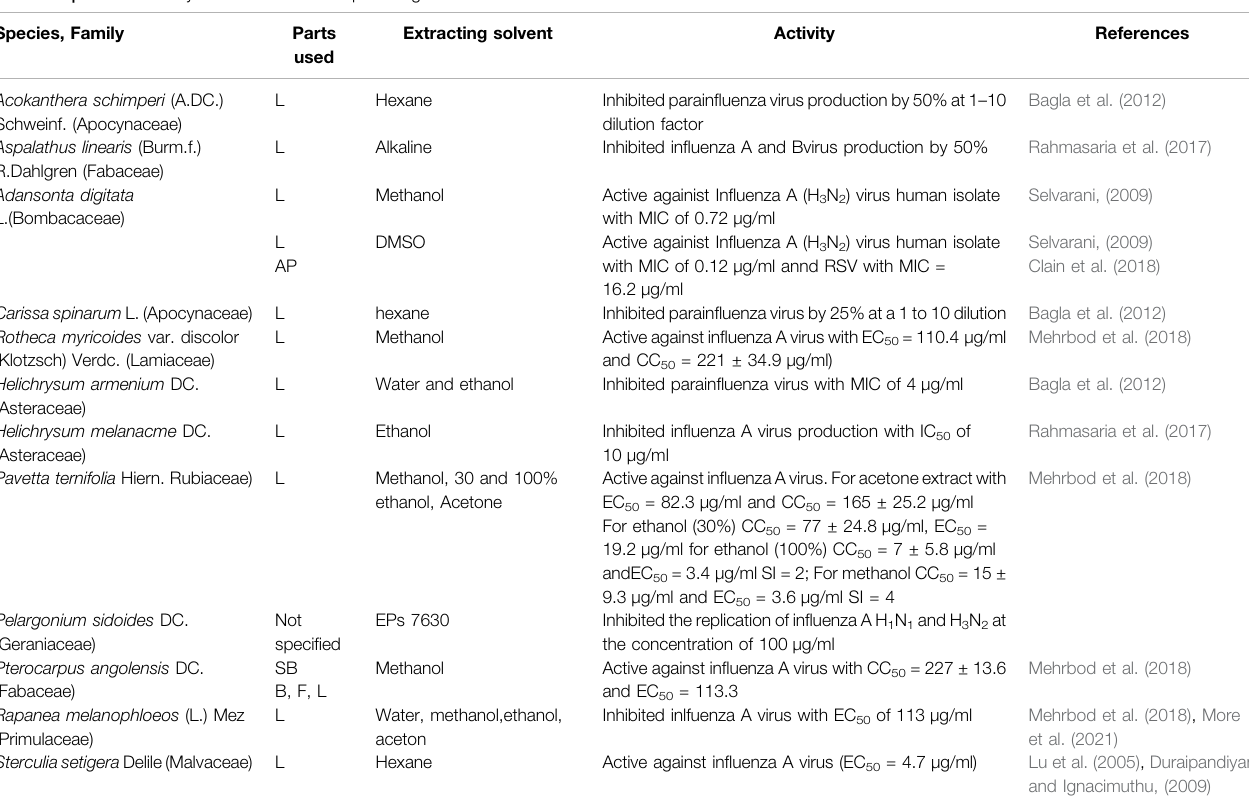
TABLE 2 | Antiviral activity of African medicinal plants against In fl uenza virus. Species,